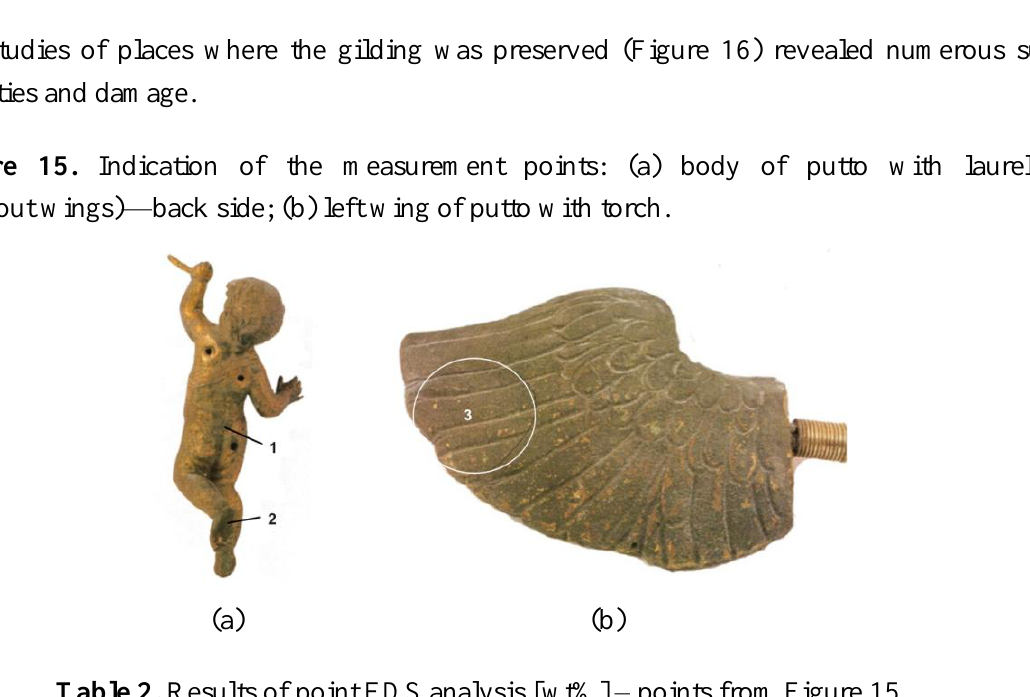
Table 2. Results of point EDS analysis [wt%] – points from Figure 15.